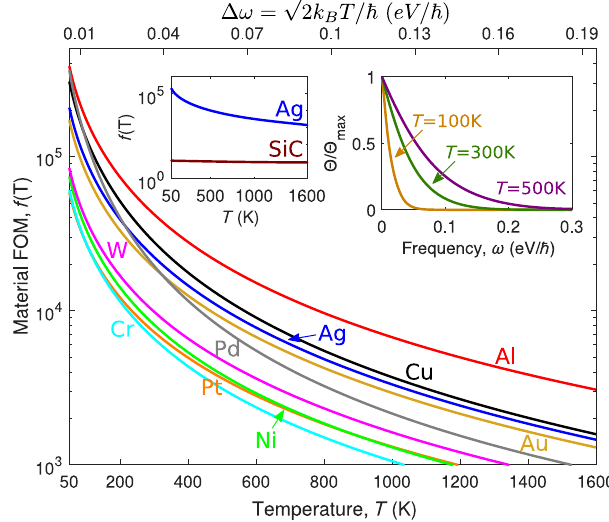
FIG. 7. Comparison of material FOM f ð T Þ in the context of NFRHT for a variety of conventional metals. The left inset shows the orders-of-magnitude difference between silver and SiC, a polar dielectric that supports surface-phonon polaritons at infra- red frequencies yet has a small material FOM due to its non- Drude-like permittivity. The right inset shows the mean energy spectrum Θ (normalized to its maximum value) at different temperatures. The decaying FOM reflects increasing loss from bandwidth, which broadens with temperature. For a practical range of temperatures as shown here, metals are superior under this metric compared to dielectrics. Generally, f ð T Þ favors materials with large plasma frequency ω p and small material loss rate γ